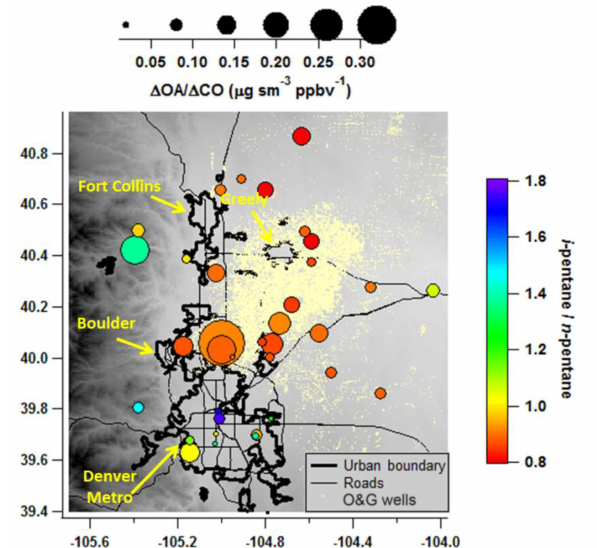
Figure 2. Enhancement ratios of OA with respect to CO in individ- ual plumes sampled in the Front Range BL. Points are sized with (cid:49) OA/ (cid:49) CO and color coded by the i -pentane/ n -pentane ratio. Only cases where the correlation coefficient ( r ) of OA vs. CO was greater than 0.5 and the standard deviation of the ODR slopes was less than 50% of the slope itself are highlighted. Locations of O&G wells are shown with yellow